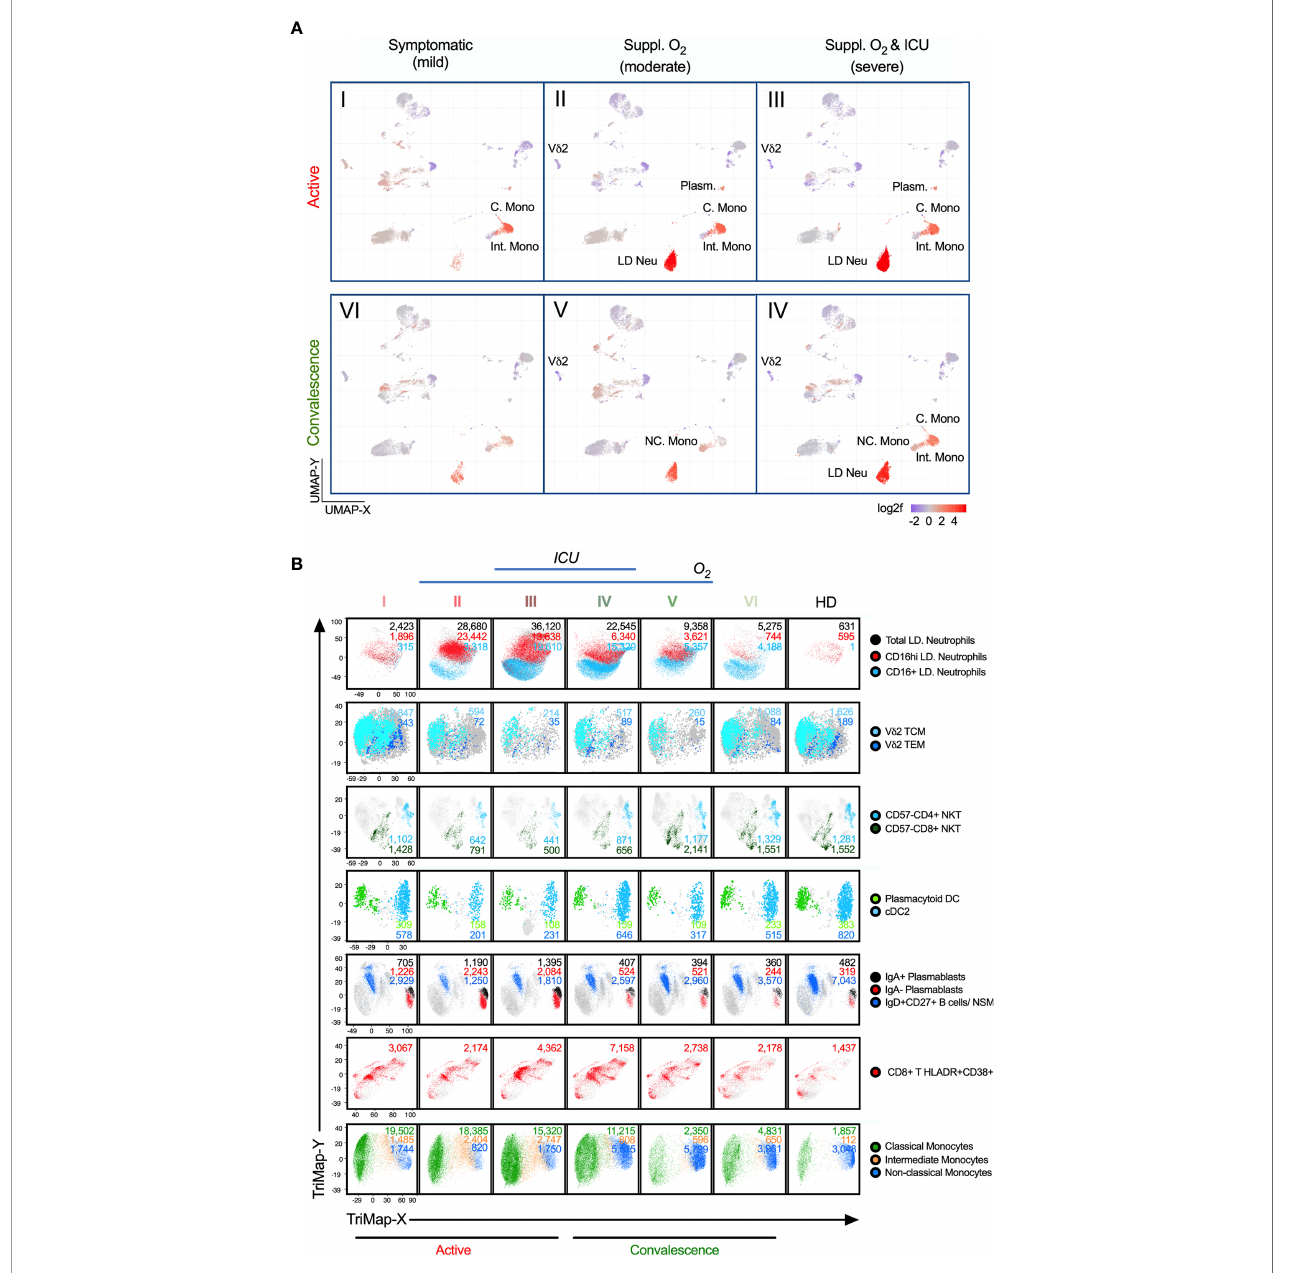
FIGURE 4 | Alterations of immunotypes associated with the six-group disease severity states. (A) Distribution of 38 immune cells among group I active mild symptomatic, group II active suppl. O 2 group III active suppl. O 2 ICU, group IV convalescent suppl. O 2 ICU, group V convalescent Suppl. O 2 and group VI convalescent mild symptomatic using UMAP clustering. Color indicates the log2 fold change in the frequency against healthy donors. (B) TriMap clustering of CD16 +/hi LD Neu, V d 2 TCM, V d 2 TEM, pan-CD57 - NKT, pDC, cDC2, IgA + / - plasmablasts, IgD + CD27 + NSM, HLA-DR + CD38 + CD8 T cells, C. Mono, Int. Mono and NC. Mono among 6 groups of SAR-CoV-2 patients and healthy donors (HD). The absolute number shown for the immune cells has been normalized per 300,000 PBMCs and thus re fl ects its